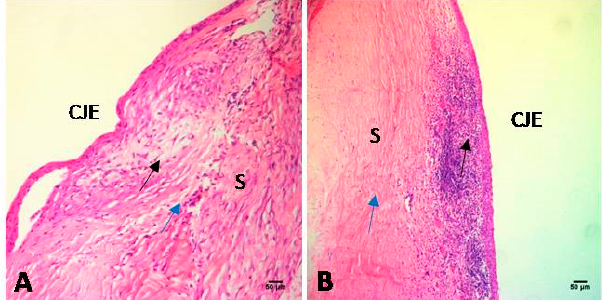
Figure 9. Histologic features of the filtration sites in the two groups on day 28 post-surgery. Loose subconjunctival connective tissue (black arrow), wide scleral spaces (blue arrow), and a few inflammatory cells were noted in the filtration area in the control group ( A ). However, fibroblast hyperplasia (blue arrow), narrow scleral spaces, and severe inflammatory cell infiltration (black arrow) were observed in the filtration area in the DED group ( B ) (200×). CJE: conjunctival epithelium; S: sclera. Scale bar = 50 μ m.